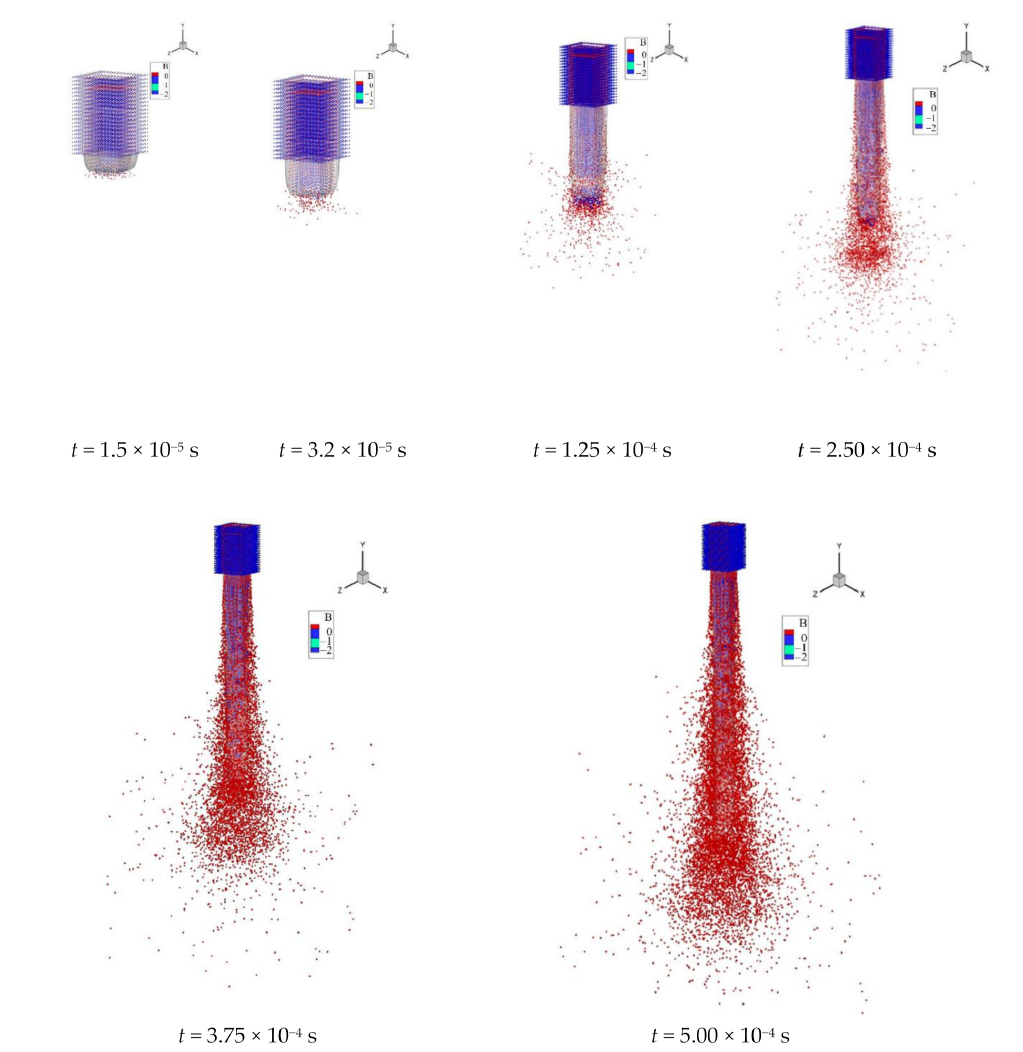
Figure 14. Comparison of liquid jet calculations in static airflow between the MPS method and the VOF (grey transparent